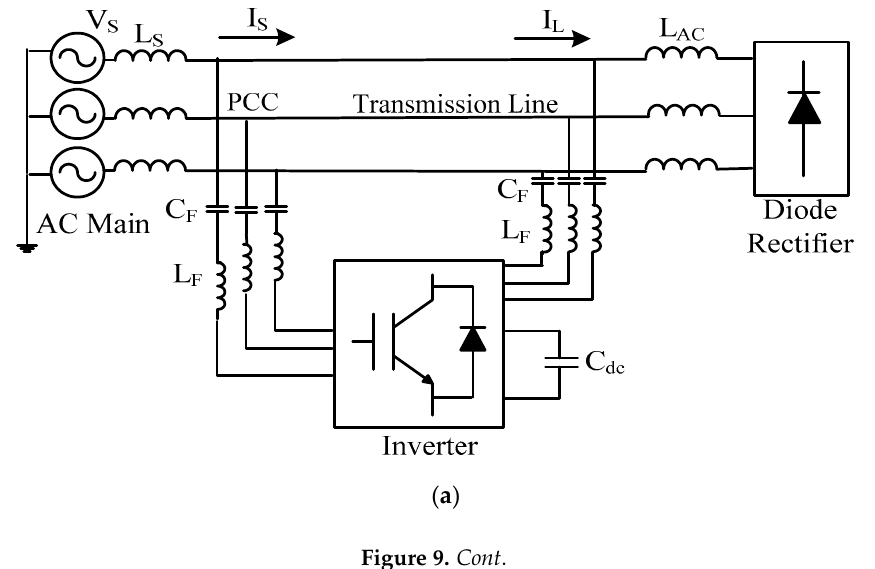
Table 6. Comparison of different DC–AC power inverter topologies.